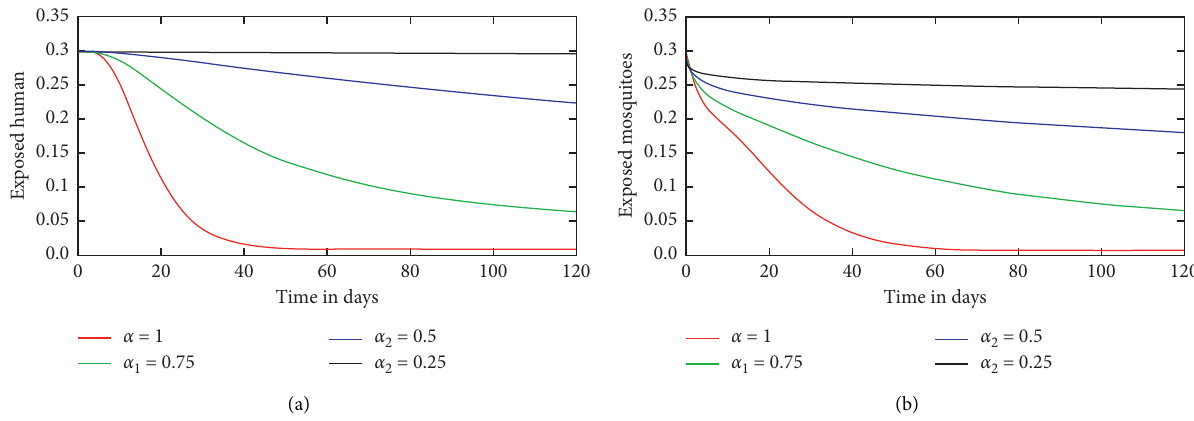
Figure 3: Variations of exposed population at α � 1, 0.75, 0.50, and 0.25: (a) exposed human; (b) exposed